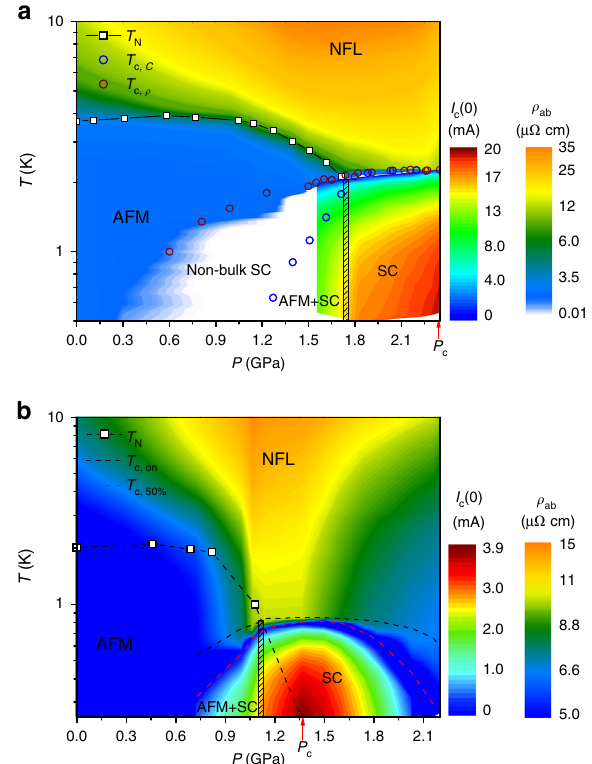
Fig. 1 Temperature – pressure phase diagrams of CeRhIn 5 and CeRhSn 0.22 In 4.78 single crystals. In the superconducting state below T c ( P ), false colors denote the magnitude of the zero- fi eld critical current I c ( P, T ). At temperatures above T c ( P ), false colors re fl ect the magnitude of the in- plane resistivity ρ ab ( P , T ). a CeRhIn 5 (Rh115) and b CeRhSn 0.22 In 4.78 (SnRh115). For both materials, ρ ab ( P , T ) is enhanced around the quantum critical point P c due to pronounced incoherent inelastic scattering. Similarly, the zero- fi eld I c ( P , T ) is largest at P c , where the QCP is expected, as indicated by the arrow. In both a and b the vertical hashed rectangle is at P c *, the pressure that separates a phase of coexisting superconductivity and magnetism from a purely SC phase for P > P c *. Open squares in both a and b represent the antiferromagnetic transition temperature ( T N ). SC transition temperature ( T c ) of Rh115 is evaluated from speci fi c heat ( T c, C ) and resistivity ( T c, ρ ) measurements, and T c of SnRh115 is determined as T c onset ( T c,on ) and 50% ( T c,50% ) of the normal state resistivity value at T c,on . AFM, SC, and NFL stand for antiferromagnetic, superconducting, and non- Fermi liquid regions,